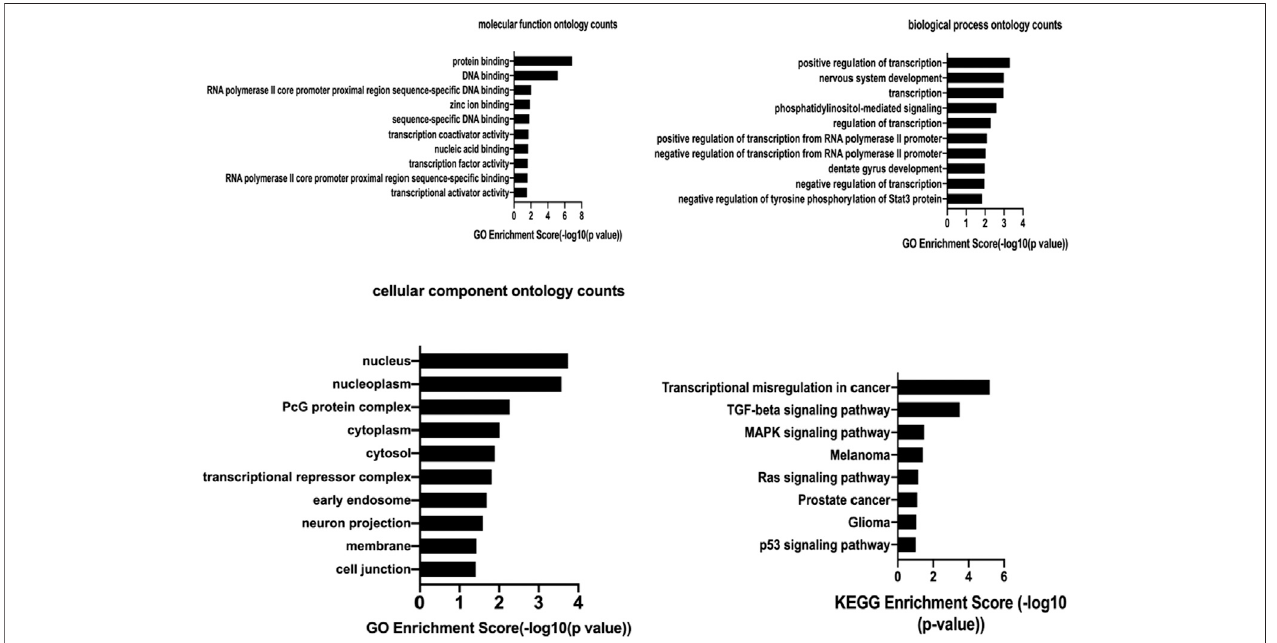
FIGURE 8 | The molecular function ontology analysis, biological process ontology analysis,cellular component ontology analysis and KEGG pathway analysis of hsa_circ_0005505. GO enrichment score and KEGG enrichment score represent the number of genes enriched in the cluster.